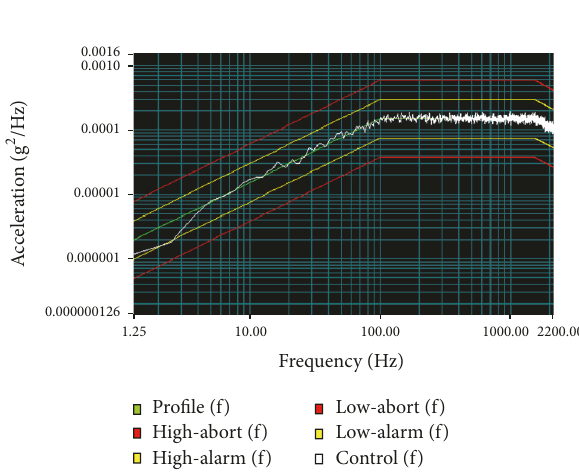
Figure 8: Random excitation spectrum used in random vibration response